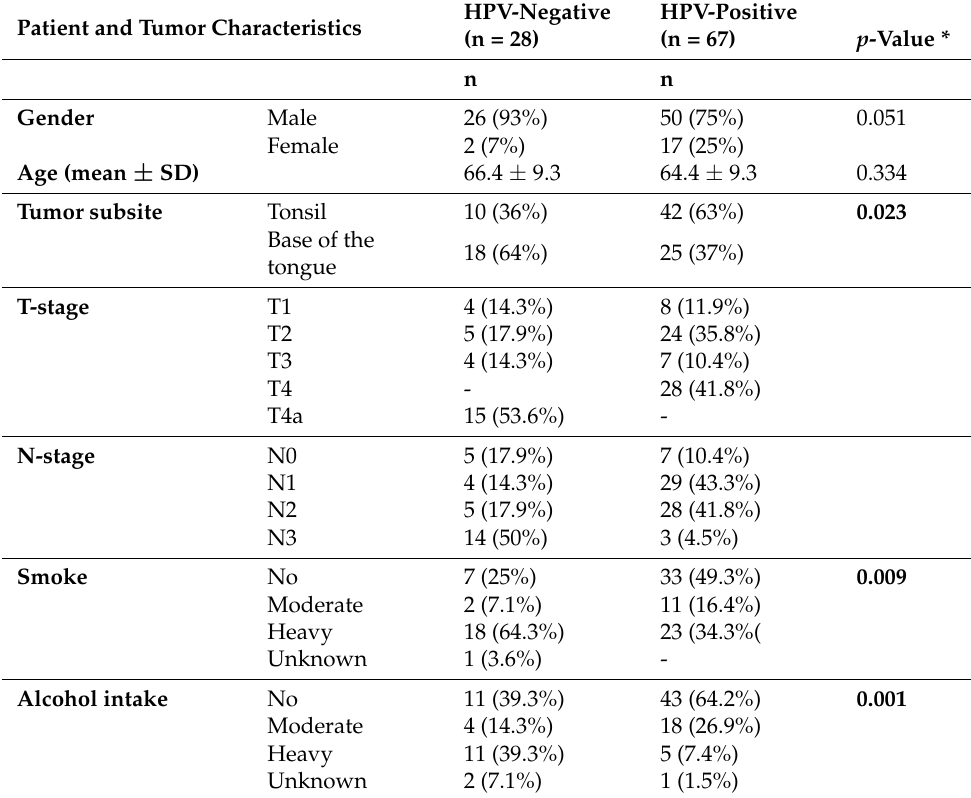
Table 1. Characteristics of patients and tumors in the training